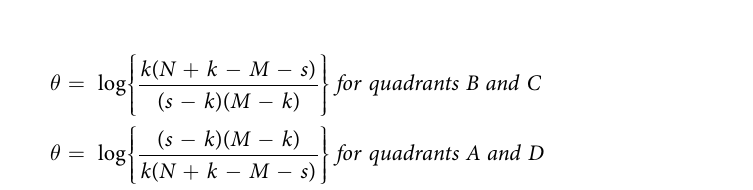
Figure 3. Interpretation of the Stratified RRHO method. A hotspot in quadrant A indicates overlap in genes up-regulated in study 1 and down-regulated in study 2. A hotspot in quadrant B indicates overlap in genes down- regulated in both studies. A hotspot in quadrant C indicates overlap in genes up-regulated in both studies. A hotspot in quadrant D indicates overlap in genes down-regulated in study 1 and up-regulated in study